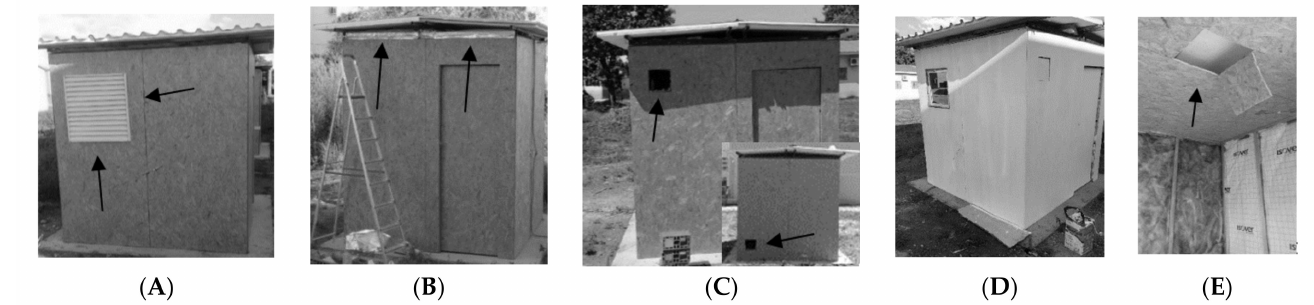
Figure 5. Implemented passive cooling techniques: ( A ) Shading of the glazed openings; ( B ) Low- emissivity reflective film; ( C ) Natural cross ventilation, due to wind effect; ( D ) Painting with reflective paint on the walls and roof; ( E ) Natural ventilation, by chimney effect.